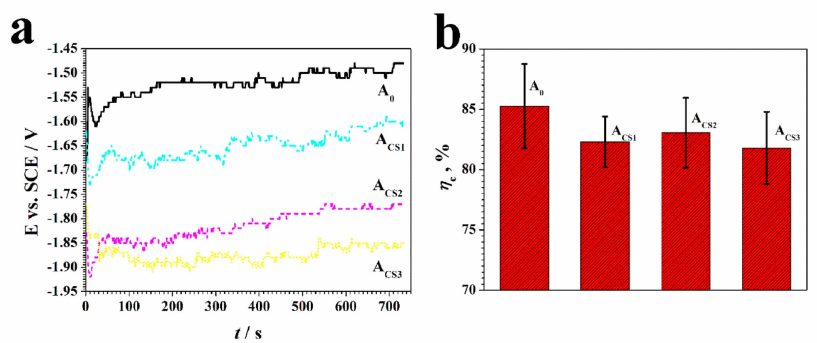
Figure 2. ( a ) The electrodepositing potential variation and ( b ) the current e ffi ciency of the coatings.